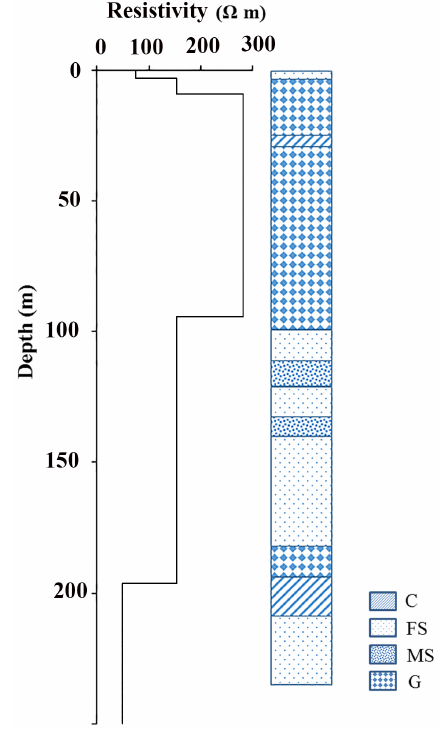
Figure 4. Inversed resistivity and corresponding stratigraphy in zone